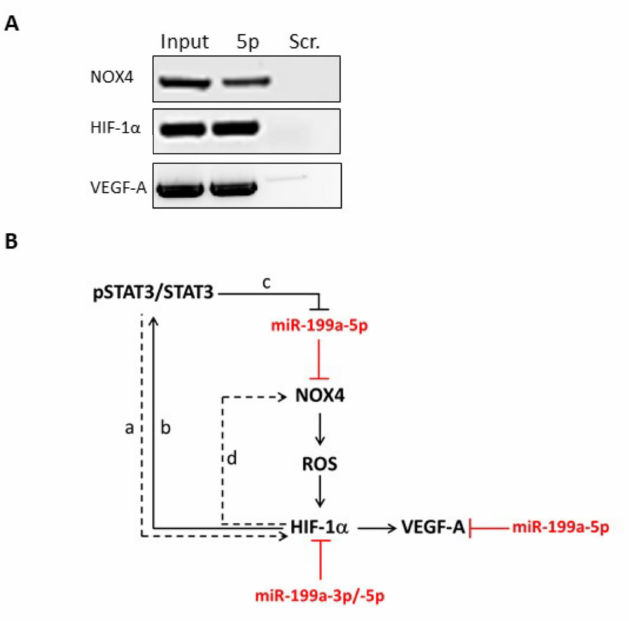
Figure 4. NOX4/HIF-1 α /VEGF-A mRNAs are direct targets of miR-199a-5p in isolated thyrocytes. Human primary thyrocytes were transfected with either a negative control (scramble) or bi-miR-199a- 5p mimic before realizing a biotin pull-down assay. NOX4/HIF-1 α /VEGF-A mRNAs were detected in human thyrocytes transfected with the bi-miR-199a-5p mimic, while no expression was observed in thyrocytes treated with the scramble probe ( A ). By regulating NOX4/HIF-1 α /VEGF-A pathway, miR-199a family could play a key role in ROS production, OS and angiogenesis in the context of GD and G0 ( B ) [4,10,12,29]. Black lines/arrows are for previously identified links (a—based on Jung [35]; b–c done by Yang [36]; d by Diebold [34]); red lines represent our working